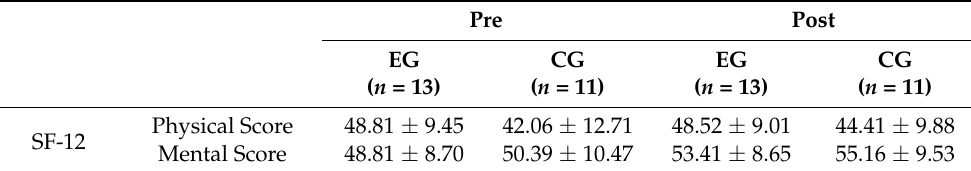
Table 4. Quality of life scores (intergroup